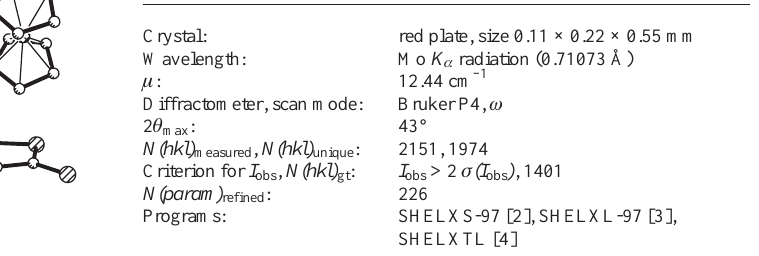
Table 1. Data collection and